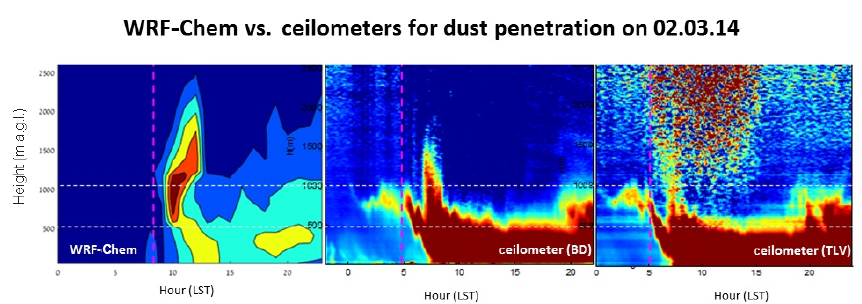
Figure 3. Comparison of the dust storm event over Israel on 2 March 2014. Dust loads of PM 10 (µgm − 3 ) processed by the WRF-Chem model version 3.5.1 for 10km resolution (left panel), 15min running average of inland ceilometer in Beit Dagan (middle panel), and onshore ceilometer in Tel Aviv (right panel). To facilitate the comparison between the three plots, horizontal lines were added to indicate the heights 500 and 1000ma.g.l. and a vertical line was added to indicate the entrance time of the dust front. The timescale is local standard time (LST), which equals UTC + 2. (In the right plot, the strong backscatter intensity in the upper level between 05:00 and 15:00LST is noise owing to poor